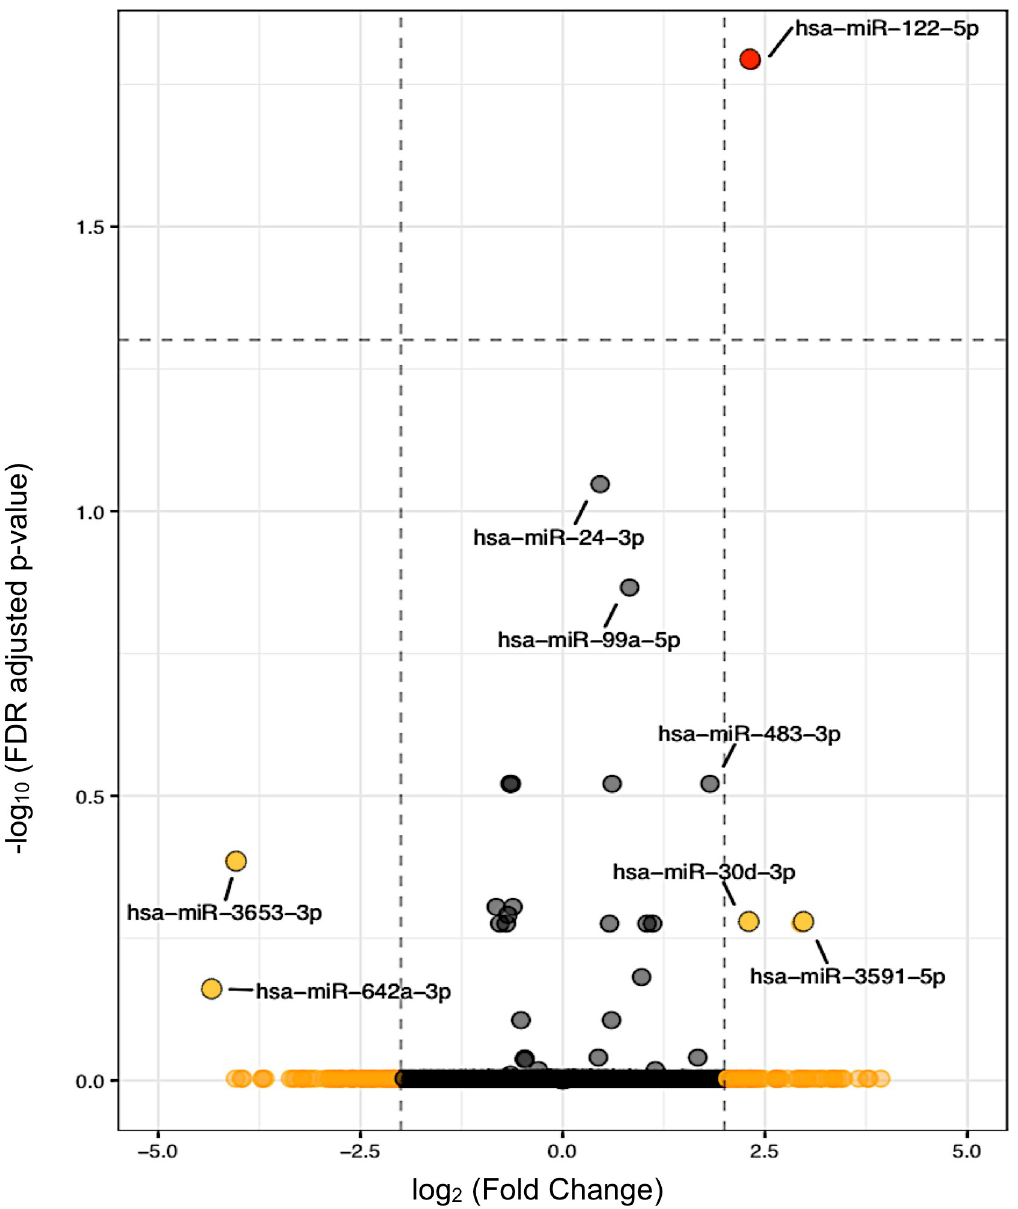
Fig 3. Volcano plot depicting miRNA differential expression in controls vs. AAA group. The dots represent the 40 miRNA that were differentially expressed as assessed by P < 0.05 before false discovery rate (FDR) adjustment. Dashed vertical lines indicate the threshold for a relative expression fold change (FC) of 2 or -2-fold. The dashed horizontal line represents the threshold of a 0.05 FDR value. The red dot (miRNA-122-5p) has an absolute log2 FC > 2 and an FDR adjusted P < 0.05. The yellow dots represent miRNAs with an absolute log2 FC > 2 that were not statistically significant after FDR adjustment. FDR, false discovery rate.